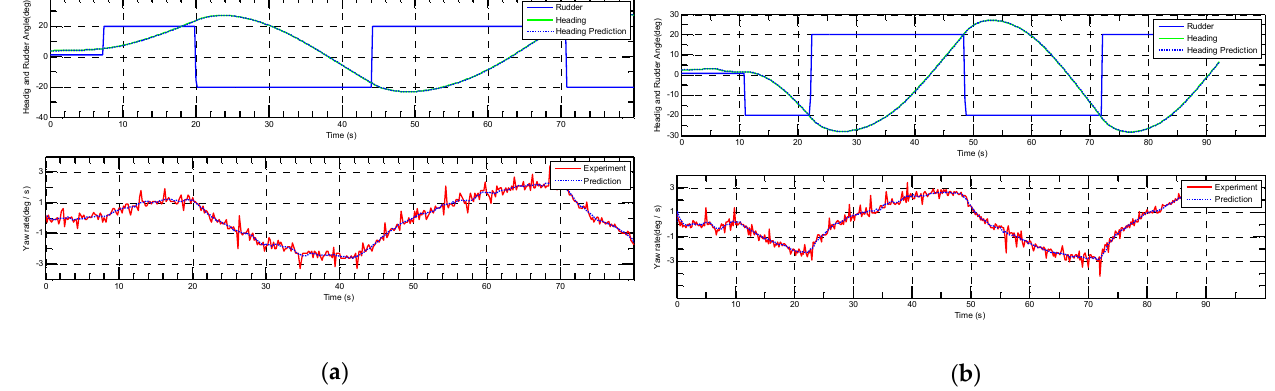
Figure 5. LS-SVM for parameter estimation using 20 ◦ − 20 ◦ zigzag manoeuvring tests: ( a ) training result; and ( b ) validation.